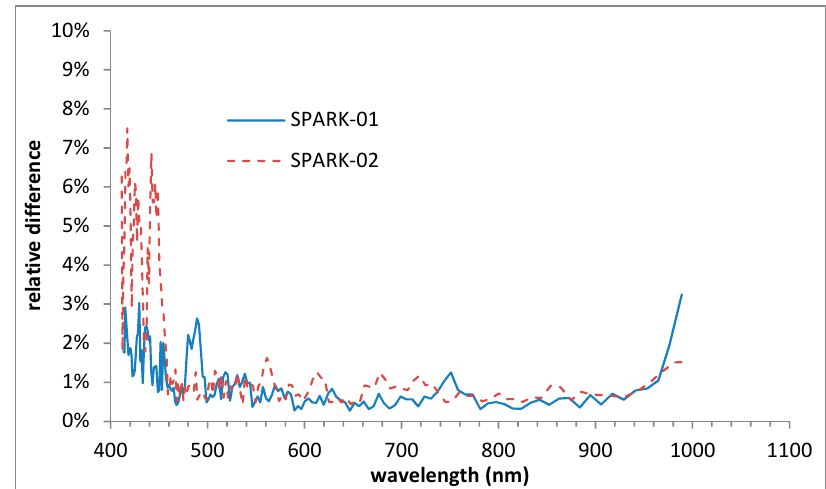
Figure 28. Averaged DNs from 6 × 6 pixel areas in the calibration site and DNs calculated by shifting the 6 × 6 pixel area by up to two pixels in all directions for SPARK-01 and -02.